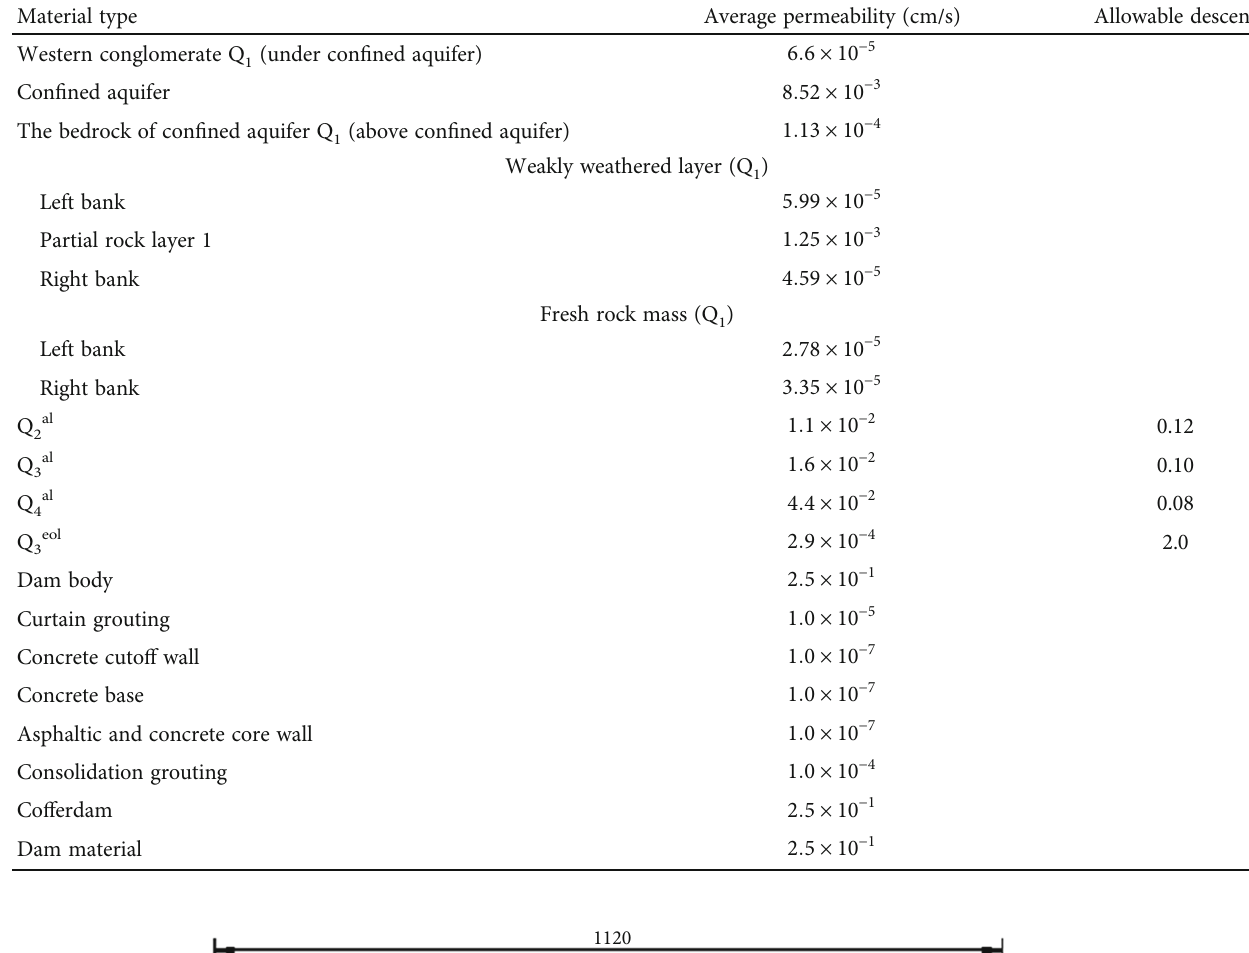
Table 1: The in fi ltration coe ffi cient and allowable